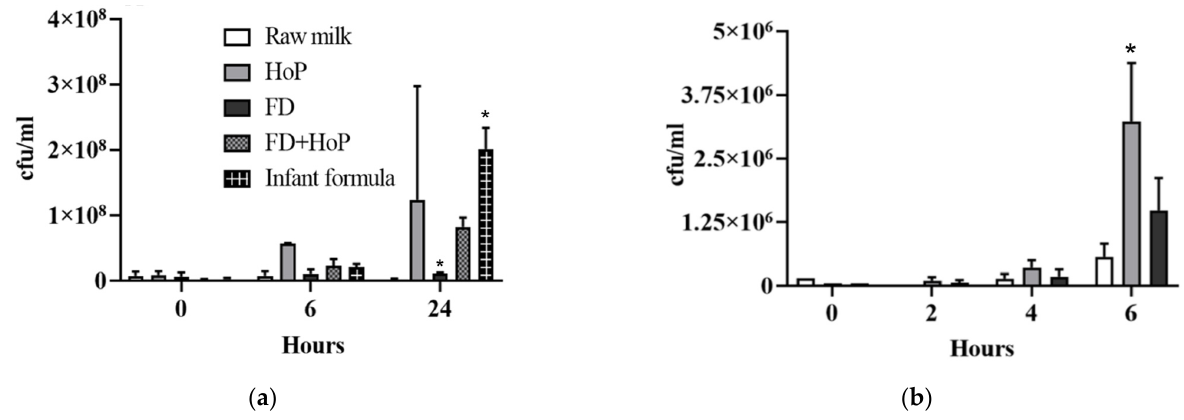
Figure 4. The microbial inhibitory effect of DHM and infant formula with respect to ( a ) S. aureus and ( b ) E. coli when processed by different techniques. Values are the means ± SD of 2 biological replicates. * Significant change in antimicrobial activity compared to raw DHM, p ≤ 0.05.